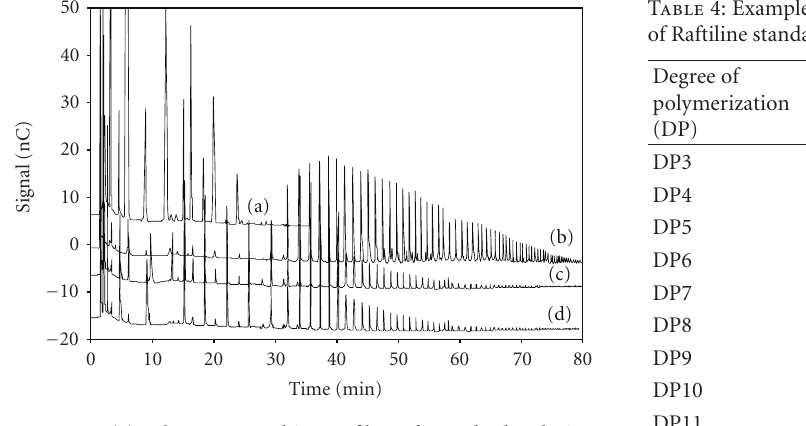
Figure 1: (a) Chromatographic profiles of standard solutions of Raftilose, (b) Frutafit TEX, (c) Frutafit IQ, (d) Raftiline. Chromatographic conditions as in the text.